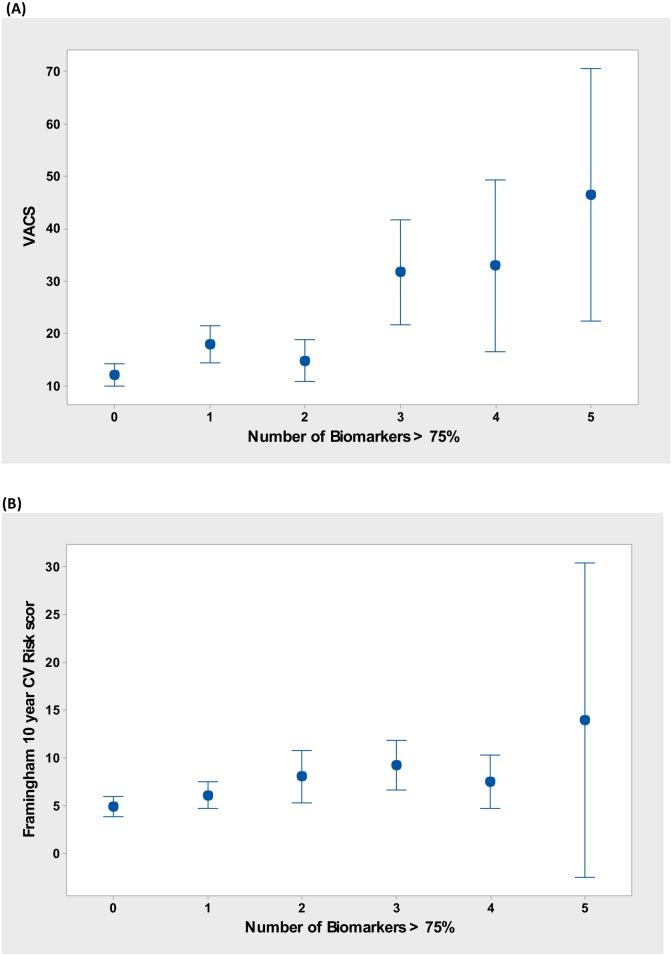
Predicting (A) VACS and (B) Framingham risk scores by number of biomarkers >75th percentile(.Abbreviations: VACS, Veterans Aging Cohort Study score; CV, cardiovascular.